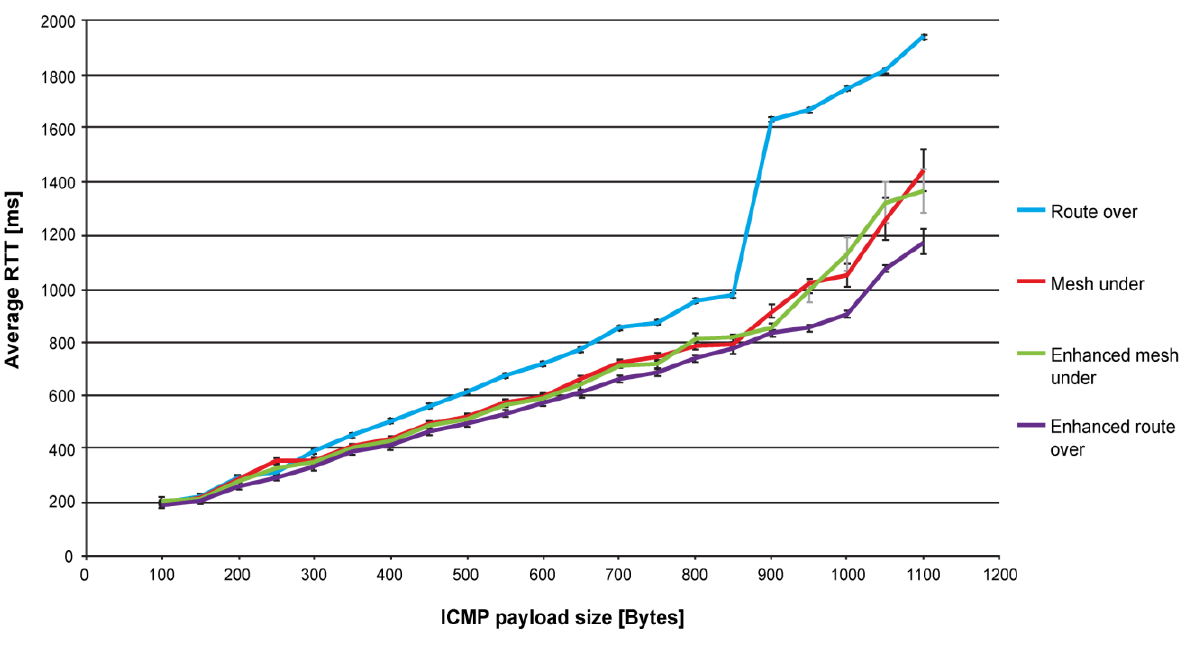
Figure 4. Round-trip delay time evolution according to ICMP payload size. Buffer congestion affects route over when reaching a payload size of 900 bytes, causing the big jump in the average round-trip delay